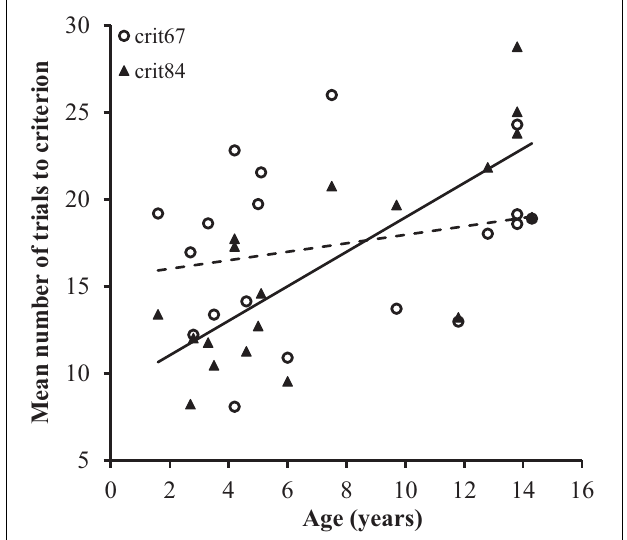
FIGURE 1 | Mean number of trials to achieve the criterion of 67 or 84% of correct responses as a function of the Age of the participants and Learning Criterion. The dotted line corresponds to the criterion